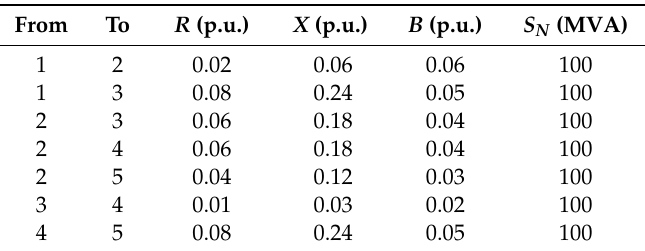
Table 2. Parameters of the AC lines.